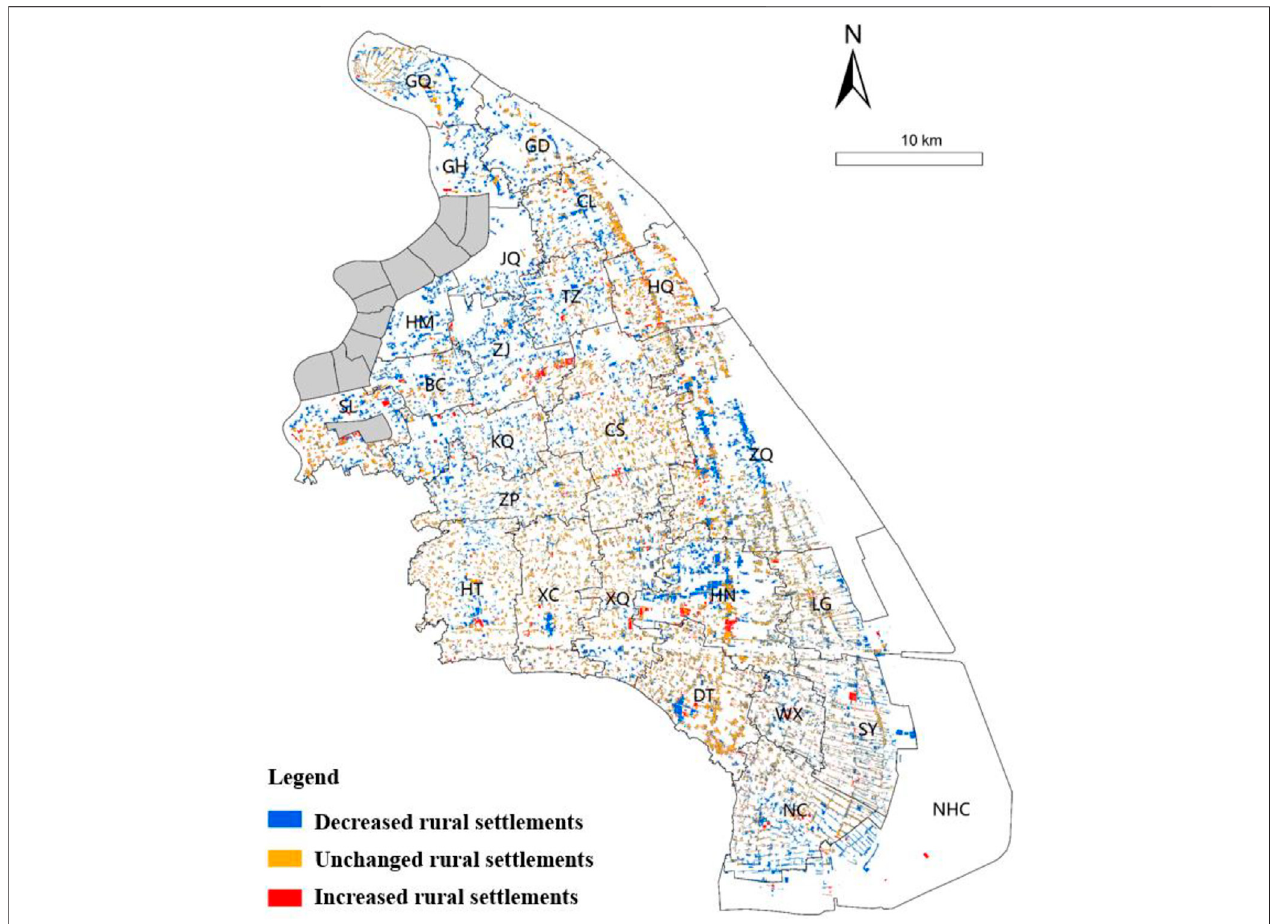
FIGURE 3 | Spatial distribution of rural settlement conversions in Pudong from 2000 to